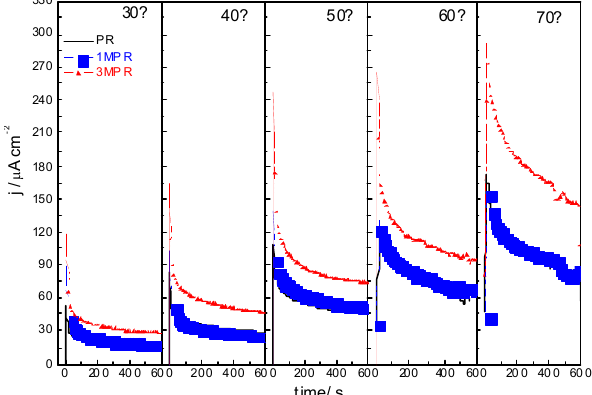
Figure 13. Current-time curves for ethanol oxidation at 0.5 V vs. RHE recorded at PR, 1MPR and MPR catalysts at 30, 40, 50, 60 and 70 °C in 1 M CH with permission from Int. J. Hydrogen Energy 2012, 37 , 7131 [47]. Copyright 2012. Elsevier.